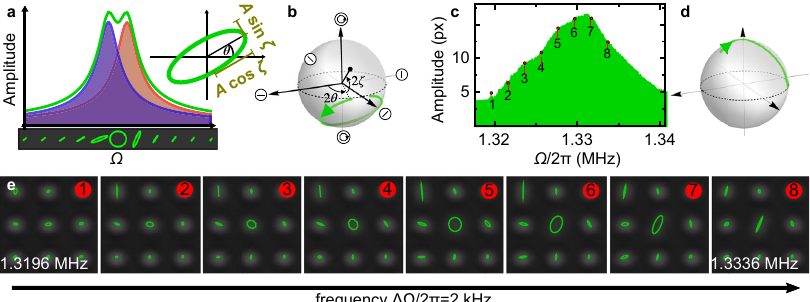
Fig. 2 Polarization physics in a single nanopillar. a Example of a theoretical frequency response for two separate orthogonal modes of a pillar (blue and red) and the combined response (green). The evolution of the trajectory along the frequency axis is indicated below the diagram. An additional inset shows the nomenclature for an arbitrary elliptical trajectory with semi-major (minor) axis length A cos ζ ( A sin ζ ), and orientation of the major axis θ . b Theoretical trajectory for the example in a on the Poincaré sphere. Note that the motion is (counter-)clockwise in the (upper) lower hemisphere. c Measured frequency response of a pillar with nearly degenerate modes. The amplitude is expressed in units of a camera pixel, where 1 px corresponds to approx. 28 nm. The corresponding path on the Poincaré sphere is shown in d . Note that we cannot measure the circulation sense of the ellipse in the experiment, therefore the path is depicted on the upper hemisphere for convenience. e Experimental evolution of the pillar's trajectory with drive frequency in the center of the images. The central pillar indicates the transition between the two orthogonal vibration directions via an elliptical trajectory. Frequency steps between neighboring images are ΔΩ = 2 π × 2